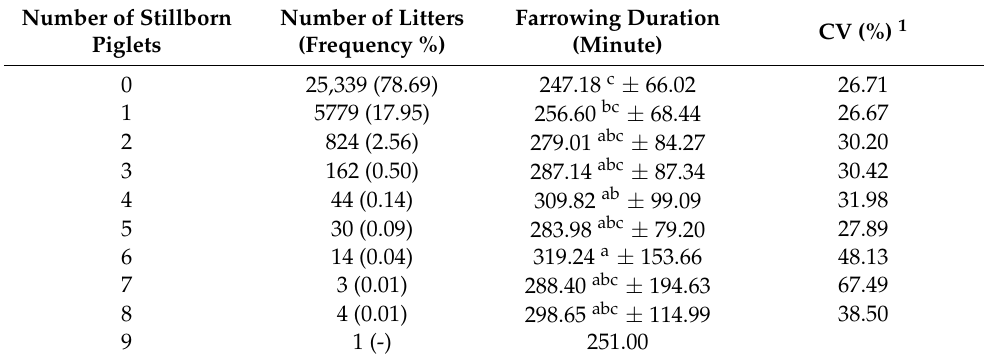
Table 3. Descriptive statistics of farrowing duration of different number born dead piglets.